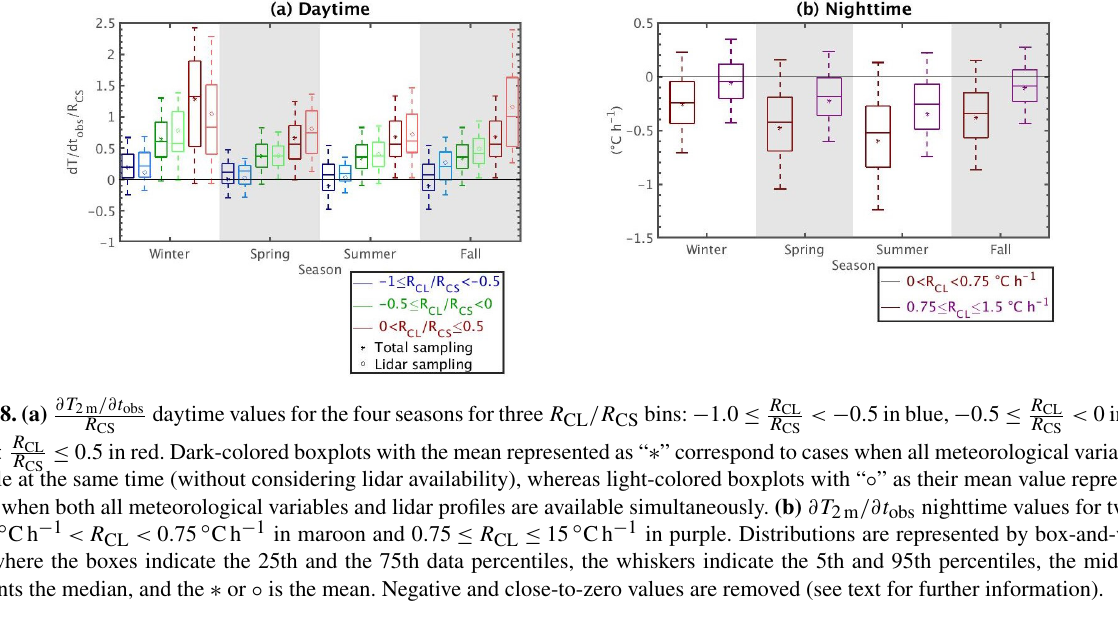
< − 0 . 5 in blue, − 0 . 5 ≤ R CL < 0 in green, R CS R CS